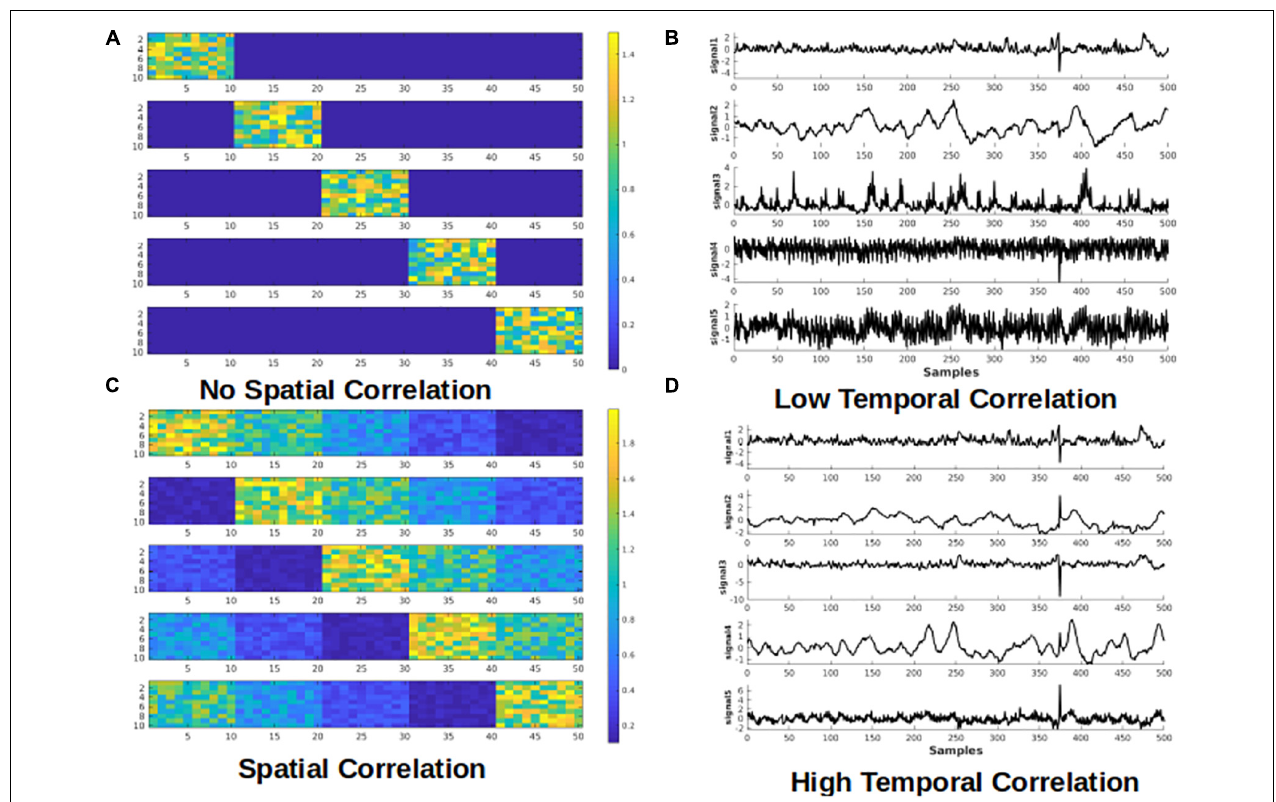
FIGURE 1 | Simulated test cases. Examples of spatial (A,C) and temporal (B,D) components used for the simulation. Examples of the spatial maps of the five components are presented on the left. Each component has dimensions of 10 × 50. Examples of temporal signals of the five components are presented on the right. Each component has 500 time samples (time points). Panels (A,B) show the cases that the components have low correlation, whereas the panels (C,D) represent the cases where the components are highly